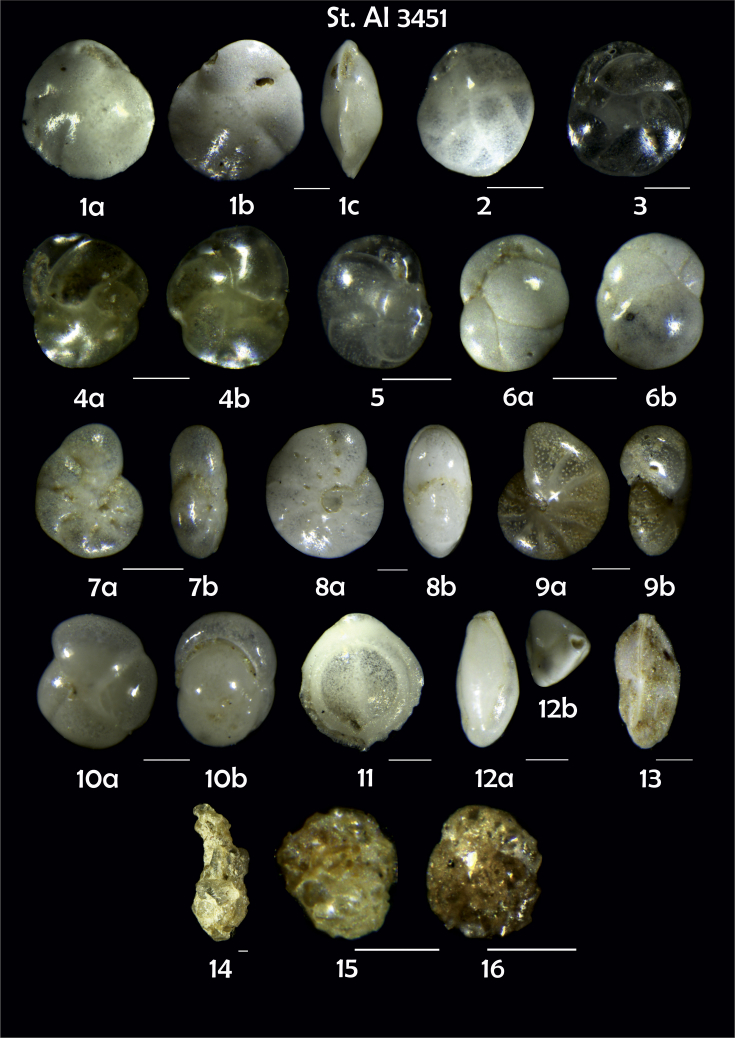
Station 34511Cassidulina laevigata, a apertural view, b,c lateral view?. 2 C. laevigata. 3C. teretis. 4Cassidulina sp., a apertural view, b lateral view. 5, 6C. reniforme, a apertural view, b lateral view. 7Elphidium sp. cf. E. excavatum, a lateral view, b apertural view. 8E. excavatum.9Melonis barleeanus,a side view, b apertural view. 10Pullenia bulloides, a side view, b apertural view. 11Pyrgo sp. 12Triloculina tricarinata, a lateral view, b apertural view. 13Trifarina angulosa. 14Lagenammina difflugiformis. 15 ?. 16Psammosphaera fusca. Scale 100 μm.